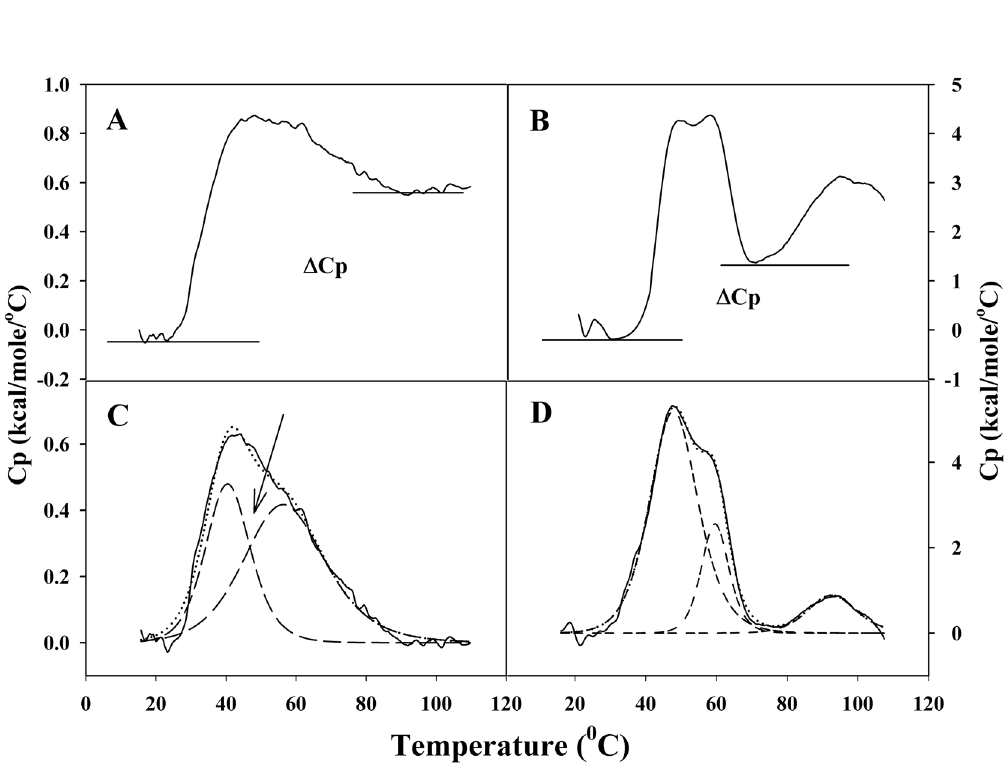
Fig. 2. Differential scanning calorimetry. DSC thermograms of C-214-HrpZ Pss (A) and full length HrpZ Pss (B). The scan rate was 60 o .h 2 1 . The change in heat capacity ( D C p ) of the native protein and the denatured state are shown. Deconvolution of DSC thermogram of C-214-HrpZ Pss (C) and full length HrpZ Pss (D). The experimentally obtained thermograms are shown as solid lines, individual transitions deduced from deconvolution analysis are shown as dashed lines and the sum of the transitions obtained from deconvolution analysis are shown as dotted lines.